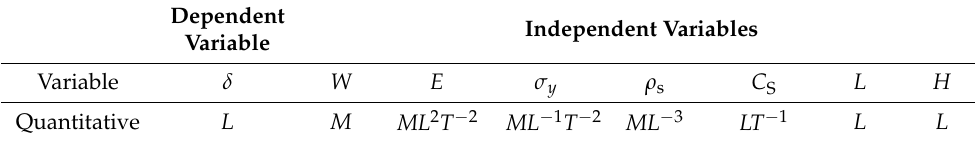
Table 2. Variables and quantitative. Dependent